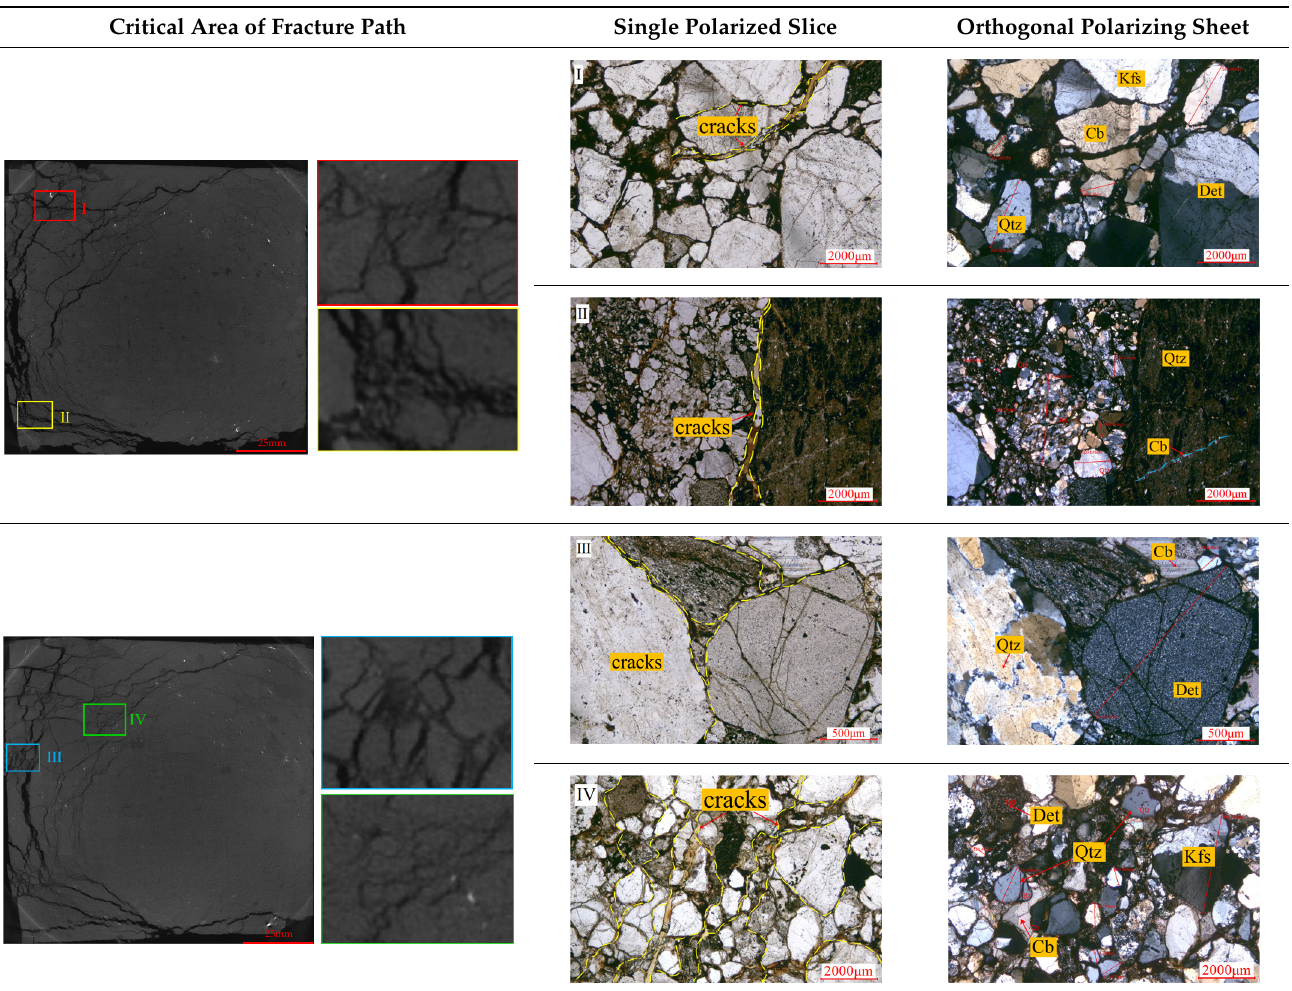
Table 3. Distribution of mineral characteristics in key areas of the fracture path. Area I is a region containing a complex fracture network, and there are many quartz particles, feldspar, and rock debris. Area II is a region wherein the fracture extends from the end to the middle, and the particles here are very fine and diverse. Area III contains the intersections of secondary fractures and main fractures. The mineral particles are mostly quartz sand and gravel with complex composition. Area IV is an area wherein the secondary fractures become concentrated.